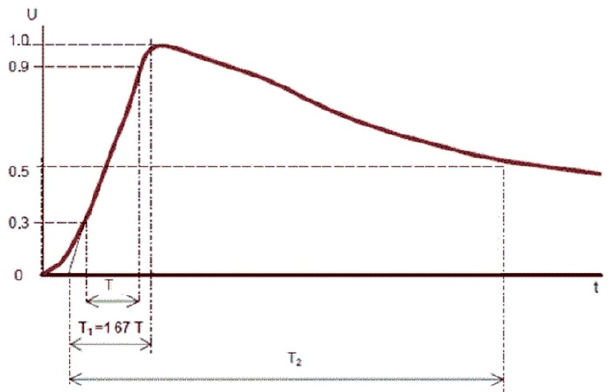
Figure 3. Lightning impulse